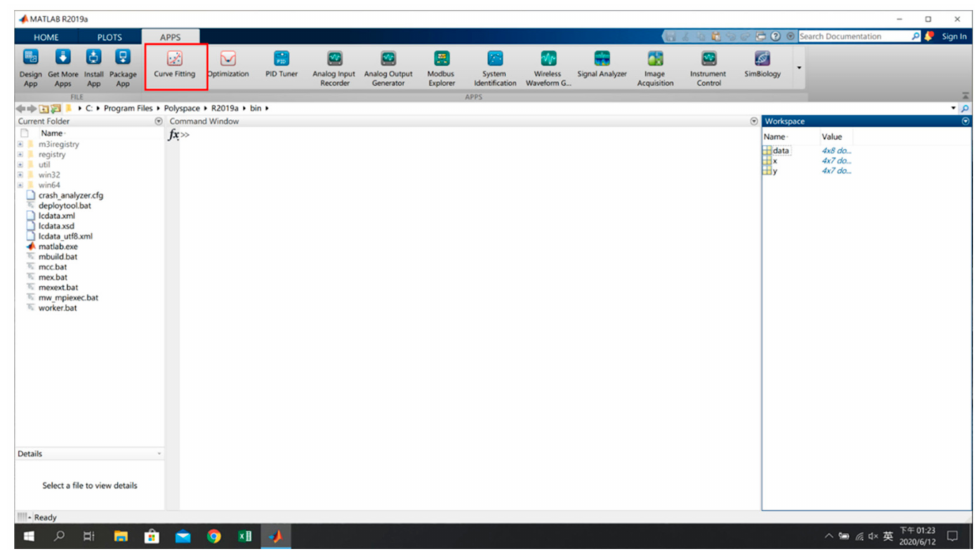
Figure 9. Curve Fitting